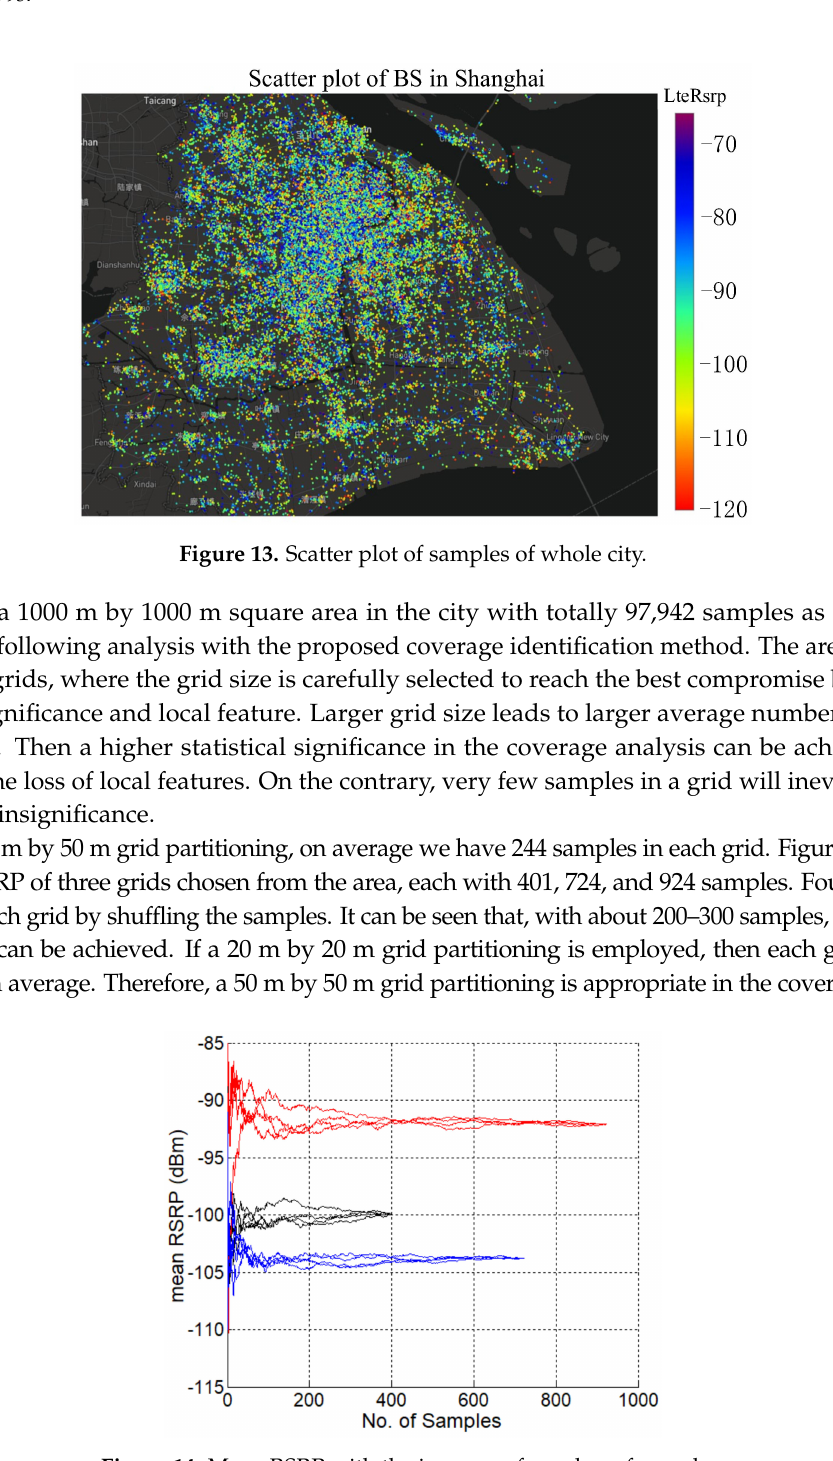
Figure 14. Mean RSRP with the increase of number of